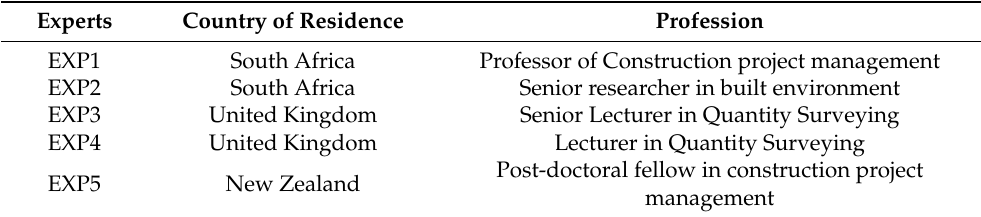
Table 2. Features of expert involved in the validation